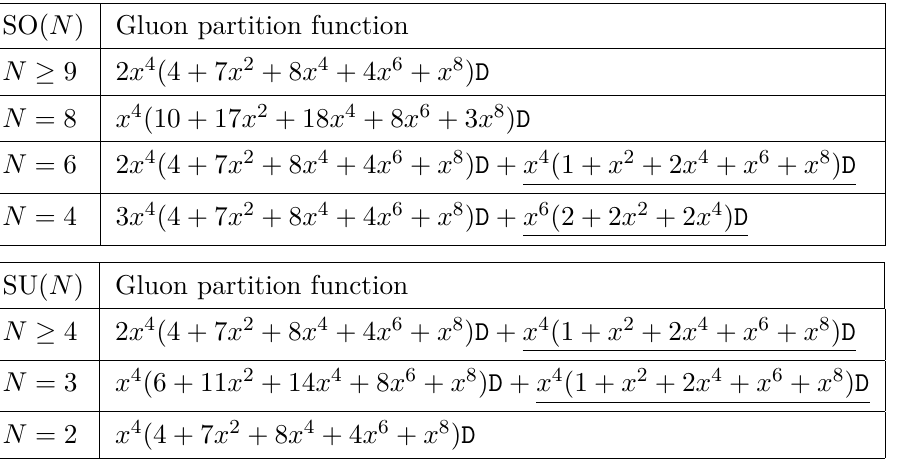
Table 6 . Partition function over the space of Lagrangians in D = 6 involving four F a D ≡ 1 / ((1 − x 4 )(1 − x 6 )) . Contribution of M non-inv is underlined. The rest is the contribution of M inv . Partition function for SO(5) and SO(7) is the same as that for SO( N ) for N ≥ 9